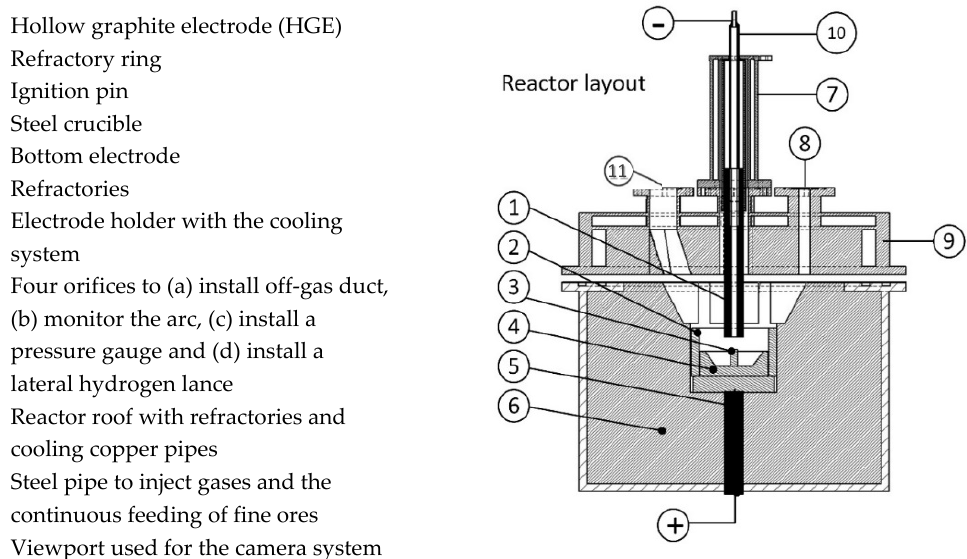
Figure 9. Reactor layout and list of the most important components reproduced from Reference [15] with permission.